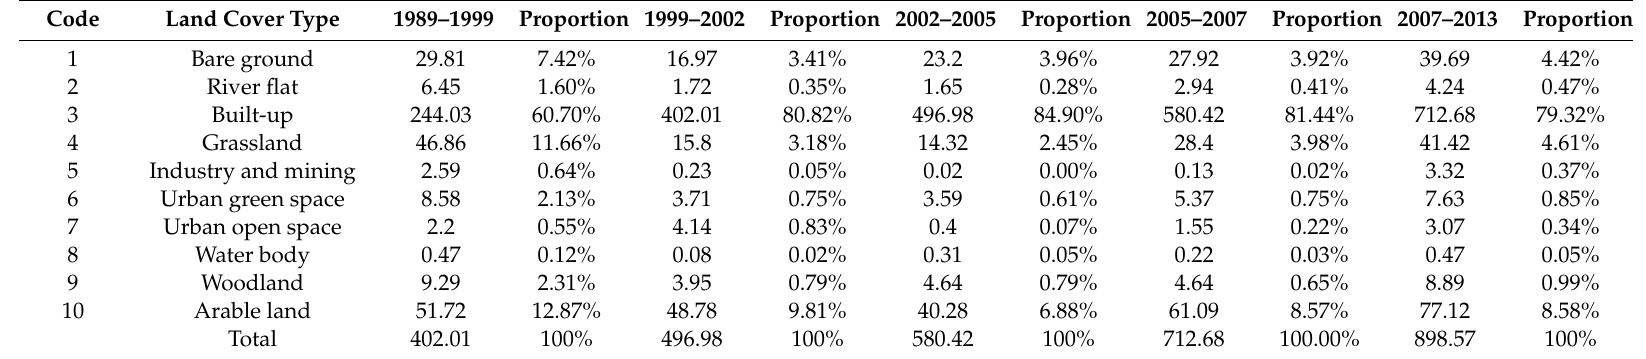
Table 7. LUCC transfer matrix for built-up areas from 1989 to 2013 (km 2